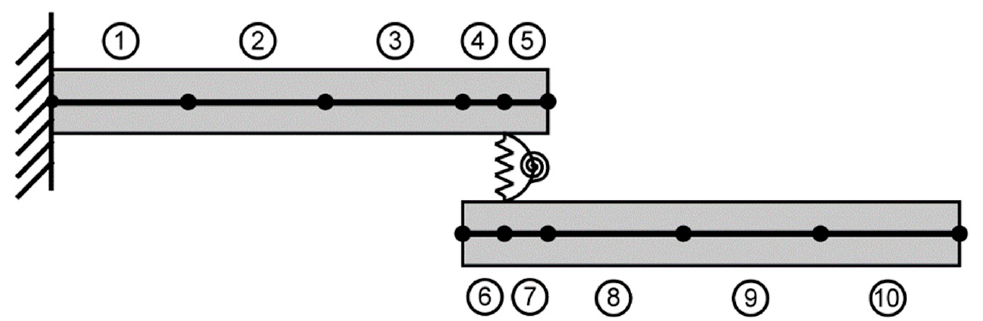
Figure 5. Mesh of the equivalent model.